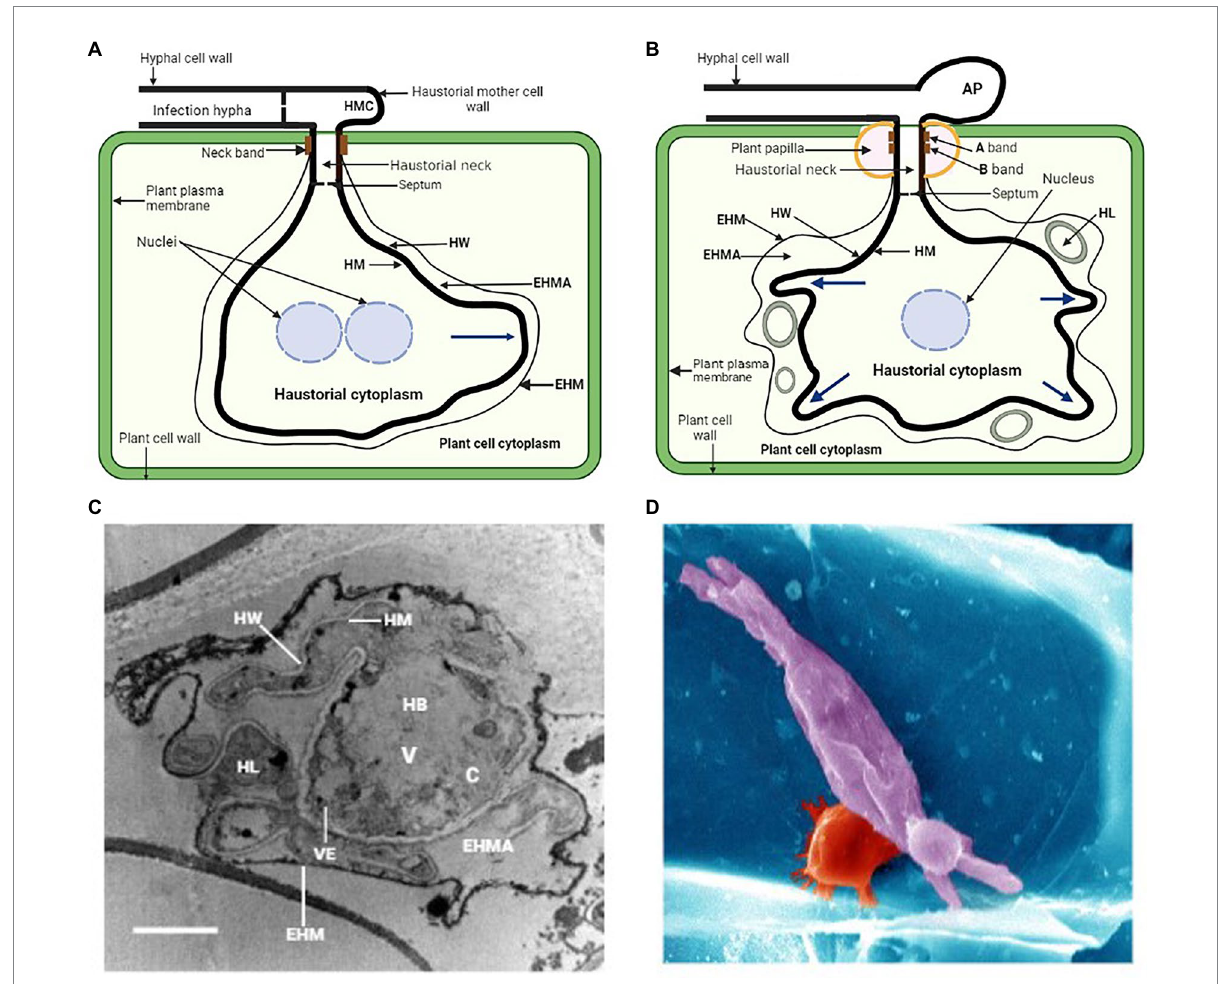
FIGURE 1 (A) General illustration of a rust fungus (dikaryon) haustorium and its association with the mesophyll cell of the host. HMC, haustorial mother cell; EHMA, extrahaustorial matrix; EHM, extrahaustorial membrane; HM, haustorial plasma membrane; HW, haustorial cell wall. (B) Schematic representation of a powdery mildew haustorial complex and its association with the epidermal cell of the host. AP, appressorium; HL, haustorial lobe. Blue arrows indicate secondary growth in these haustoria and direction of growth. (C) Transmission electron microscopy of a cross section of P. xanthii haustorial complex. The haustorial body (HB) is occupied by a large vacuole (V), a small cytoplasm (C) and many vesicles (VE). Bar, 2 μ m. Picture was taken from Martínez-Cruz et al. (2014). (D) Scanning electron microscopy of leaf epidermal cell infected with the powdery mildew causal agent, Blumeria f. sp. graminis (false colored: barley cell wall, blue; papillae, red; fungal haustorium, purple). Picture was taken from Chowdhury et al.